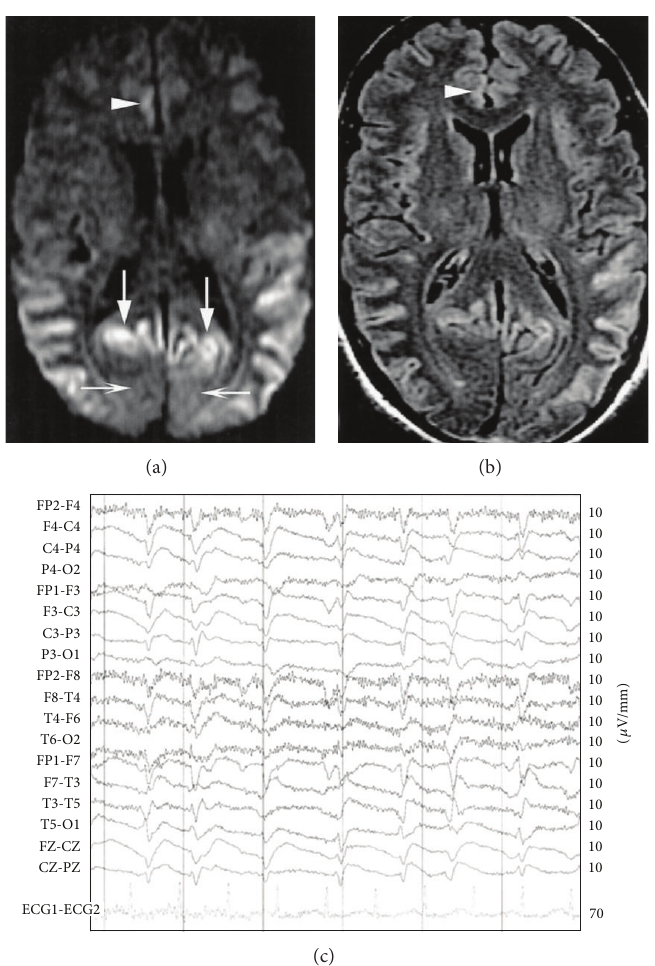
Figure 3: (a) A 50-year-old man with definite sCJD. Axial DWI shows pathologic hyperintensity in bilateral posterior temporoparietal neocortex. Cortex along parietal-occipital fissure is abnormally hyperintense (vertical arrows), but primary visual region is spared (horizontal arrows). Note asymmetric abnormal hyperintensity in right cingulum (arrowhead). Striatum is uninvolved. (b) FLAIR image at same level shows more subtle pathologic hyperintensity in all abnormal regions on DWI, as shown in cingulate cortex (arrowhead) [10]. (c) Definite sCJD (MM1); total duration: 10 months; EEG at 6 weeks: typical (used to classify case as probable); source: